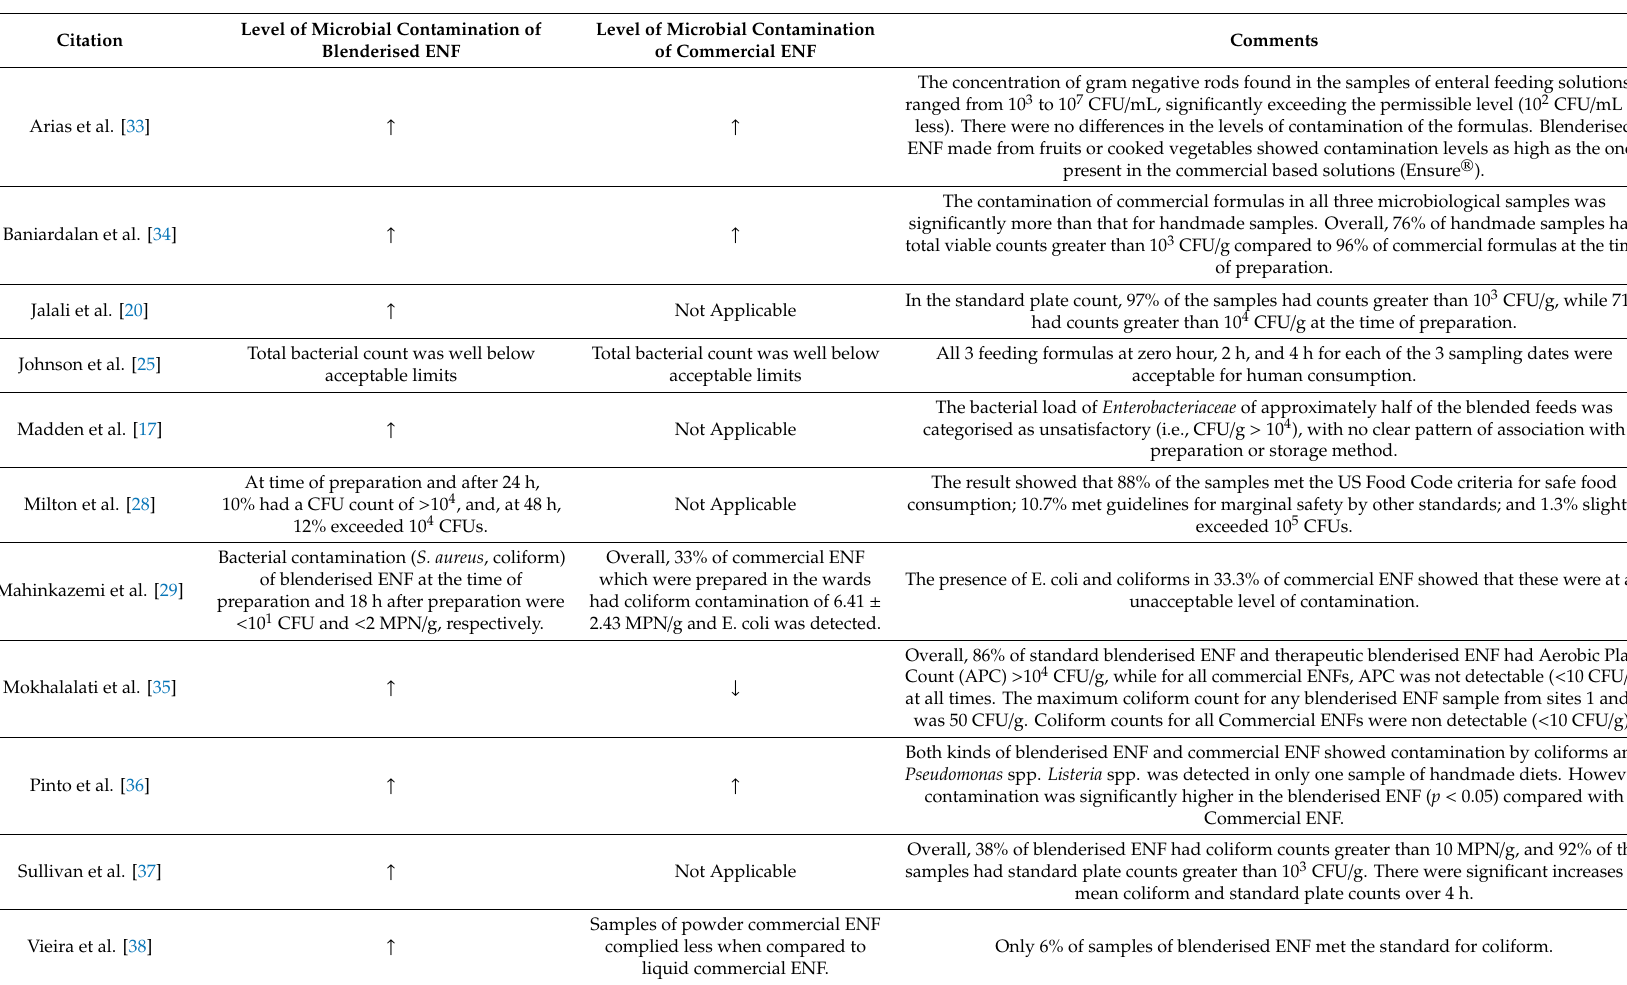
Table 3. Summary of results of the level of microbial contamination of blenderised ENF compared with commercial ENF and / or international